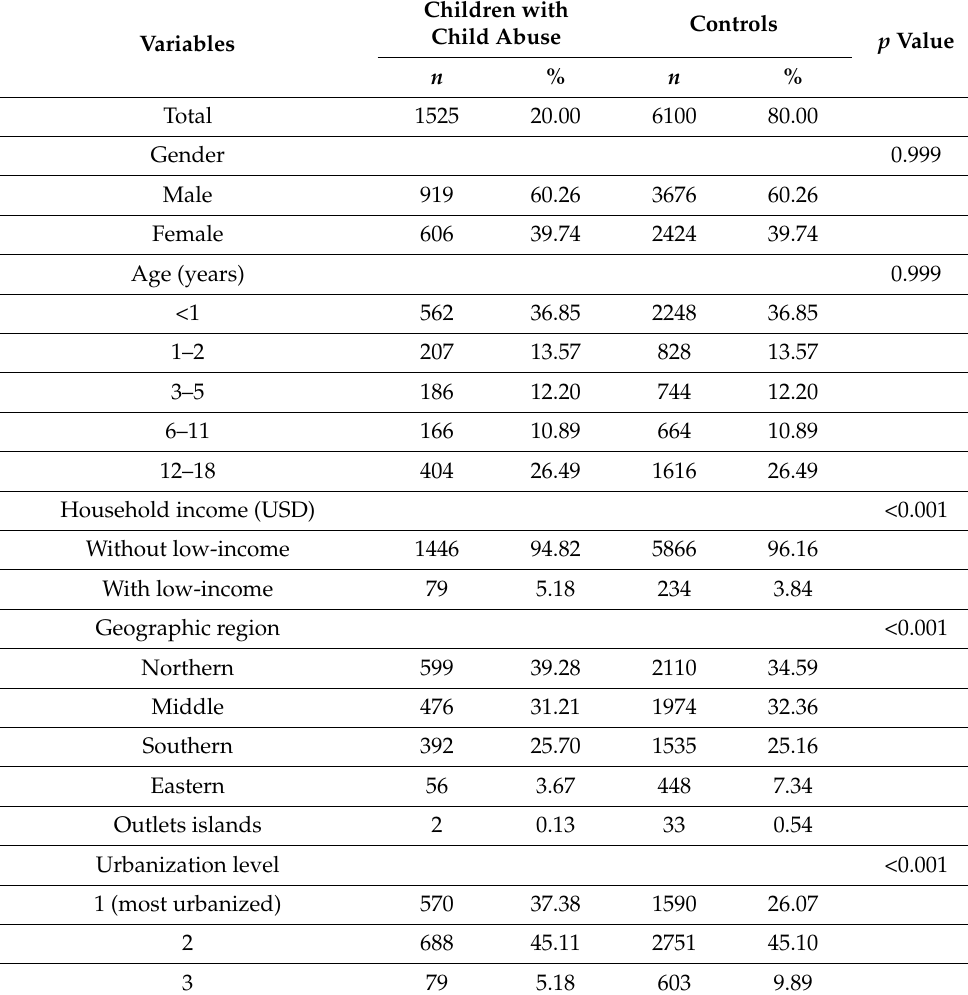
Table 1. Demographic characteristics of children with child abuse and controls ( n = 7625). Children with Child Variables